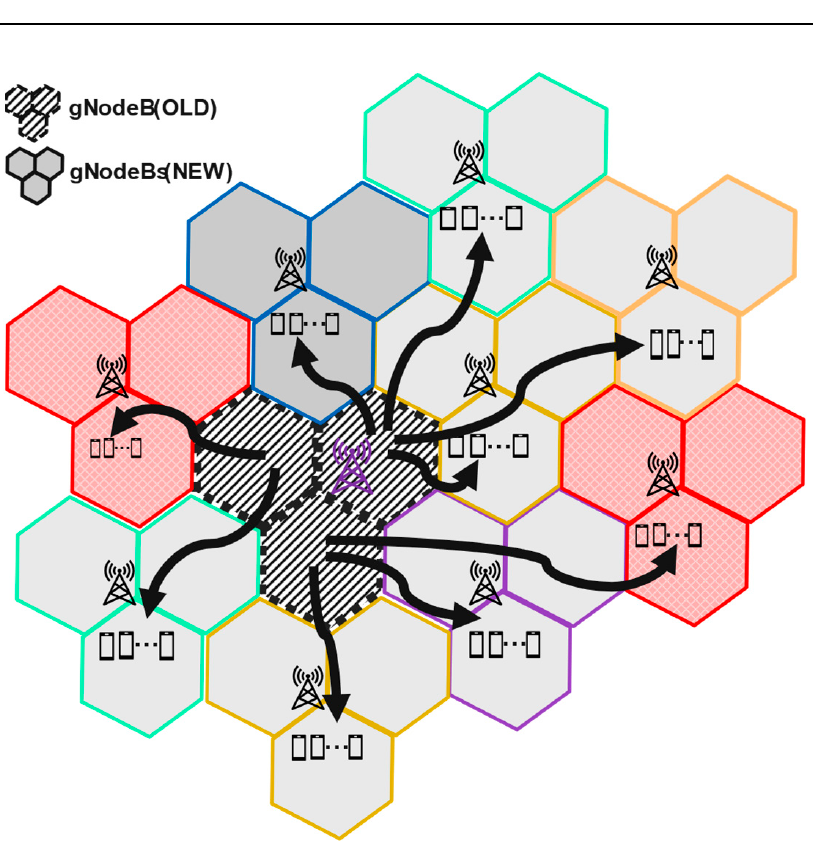
Figure 10. Example of UE movement path from gNodeB (OLD). Figure 11 shows the experimental scenario. When the UE sent a periodic or mobility registration and service request message to the AMF, the AMF stored the UE movement data in the gNodeB DB, generated the UE classifier model, and updated the machine learning paging table. When the SMF sent a service request message to the AMF, the AMF verified the UE state and performed probabilistic paging with machine